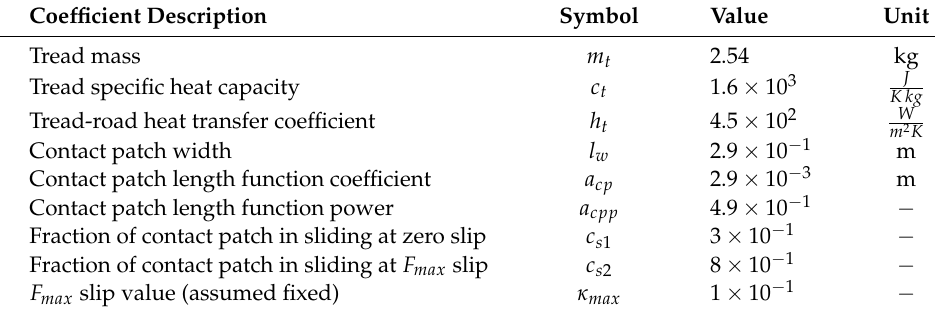
Table 1. Thermal model fixed